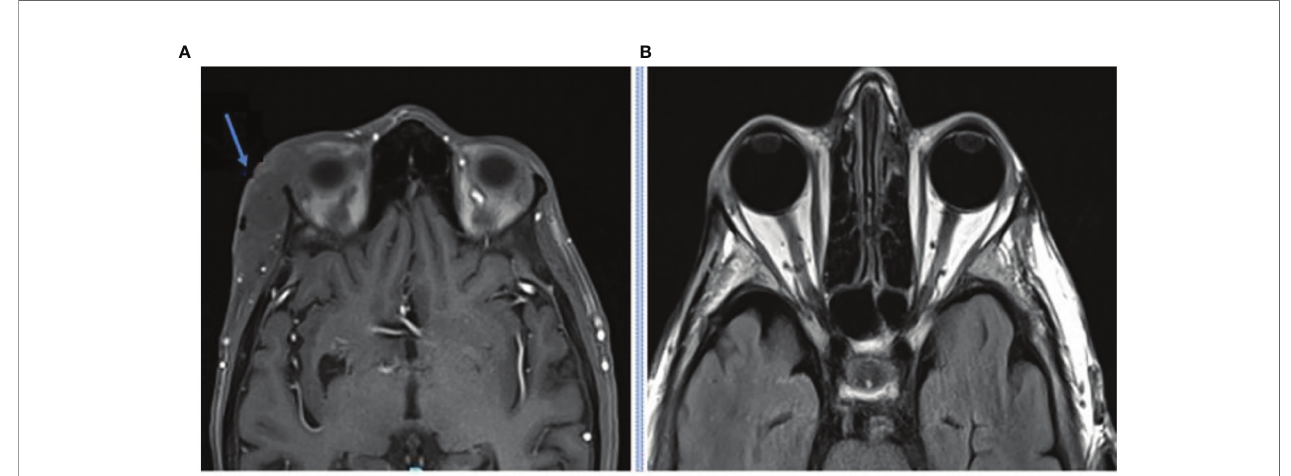
FIGURE 2 | MRI imaging at baseline (A) and after 5 months of cemiplimab 350 mg/3-weekly (B) demonstrating resolution of the soft tissue orbital